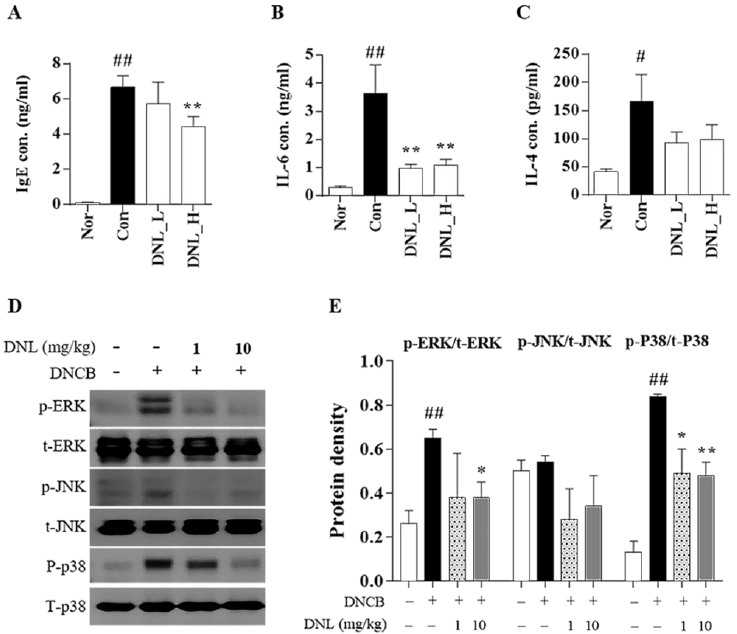
Figure 2. Effect of inflammatory cytokines and MAPK phosphorylation of DNL in DNCB-treated Balb/c mice. ( A ) Levels of IgE were measured by ELISA in serum. ( B , C ) The levels of IL-4 and IL-6 were measured by ELISA in the skin. ( D ) MAPK protein expression in DNCB-induced Balb/c mice skin was confirmed by Western blot. ( E ) MAPK was normalized to the total form of each indicator. The data are expressed as mean ± SEM ( n = 3). # p < 0.05 and ## p < 0.01, compared with the normal group. * p < 0.05 and ** p < 0.01, compared with the control